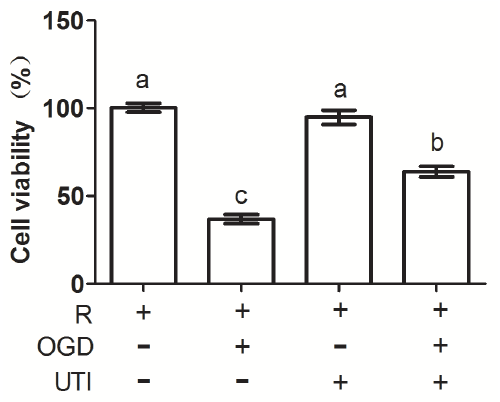
Figure 1: UTI increased the viability of renal tubular epithelial cells in OGD condition. R: Renal tubular epithelial cells; OGD: Oxygen- glucose deprivation; UTI: Ulinastatin. Bars with different letters are significantly different (p < 0.05).